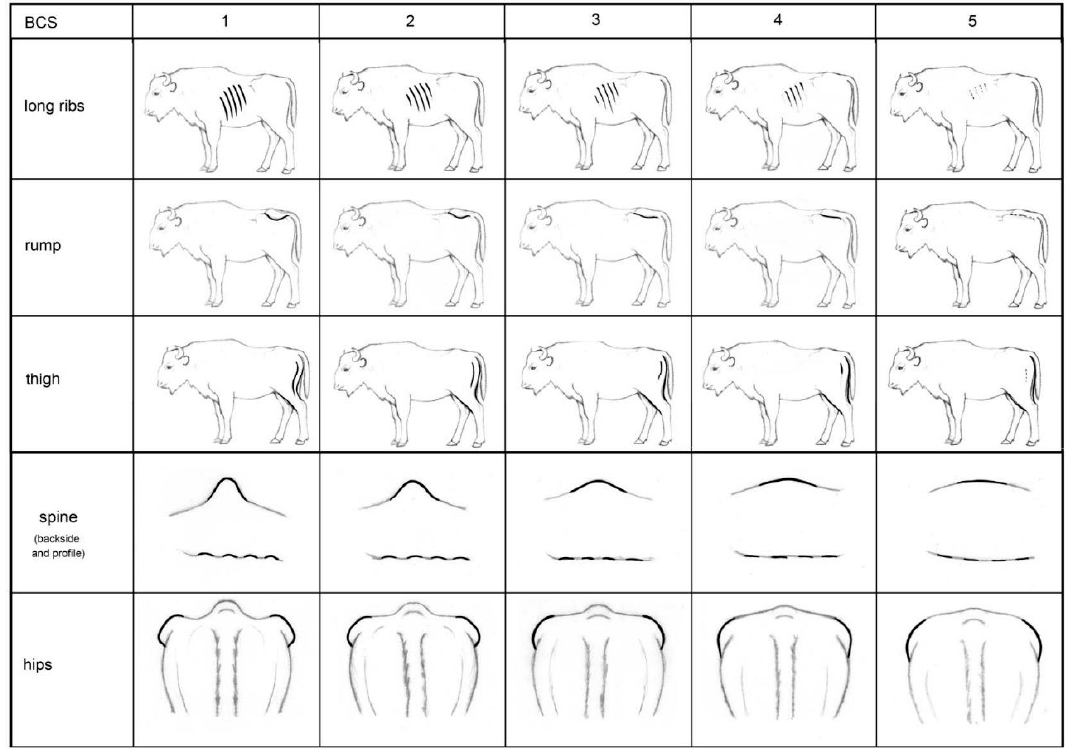
Figure 5. Simplified body condition score scheme for European bison ( Bison bonasus ) with five key areas and a five-point scale from 1 (emaciated) to 5 (obese).